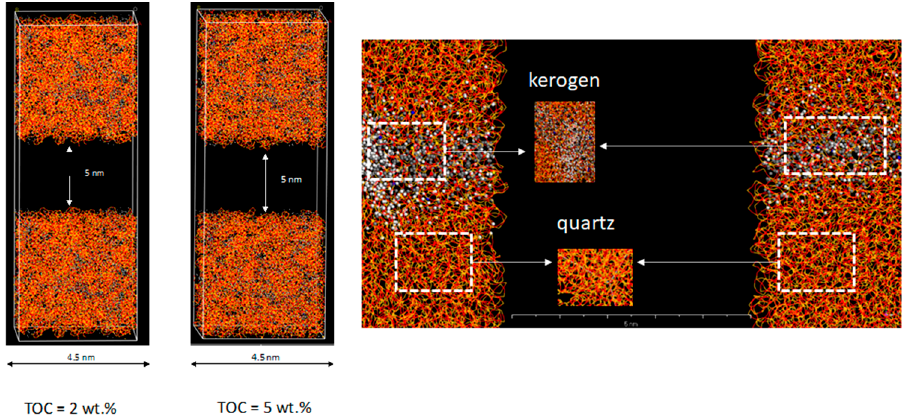
Figure 6. Schematic structure of shale slit pores.